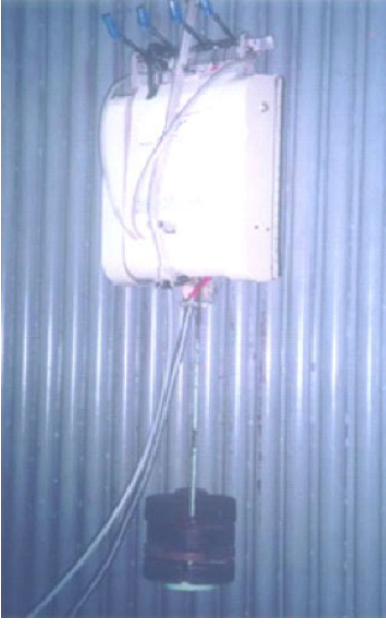
Figure 21 Wall-climbing robot for inspection of a water tube.